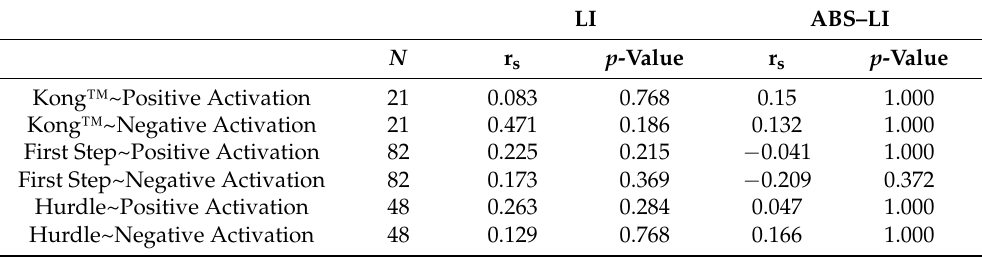
Table 3. Correlations between the LI and ABS–LI scores of the different paw preference tests (i.e., Kong™ Test, pooled First Step, and pooled Hurdle Test) and PANAS scores. Sample sizes ( N ), Spearman’s correlation coefficients (r s ), and Bonferroni-corrected p -values are